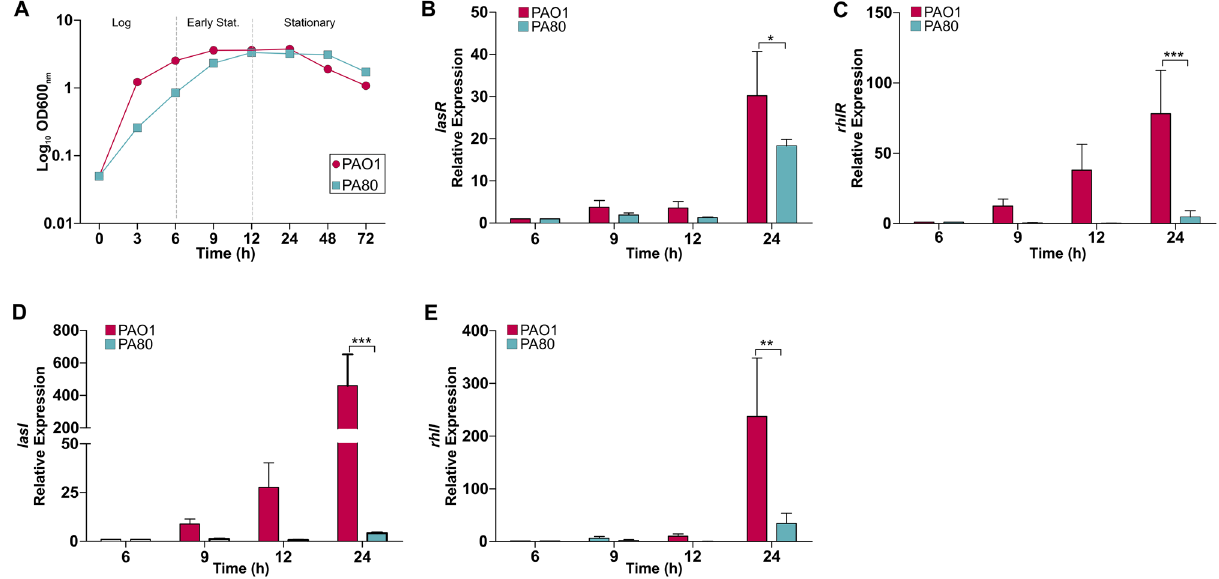
Figure 5. CF isolate PA80 does not express any QS regulatory genes. ( A ) Growth of PAO1 in comparison with rhlR mutant isolate PA80. Relative expression of PAO1 and PA80 during log and stationary growth phases. Relative expression levels of QS regulatory genes ( B ) lasR, ( C ) rhlR ( D ) lasI and ( E ) rhlI in both PAO1 and PA80. Expression levels are shown as the mean relative expression ratios to log phase levels (i.e. 6 h). Error bars represent the S.D (biological triplicates). Data was analysed using a one-way ANOVA followed by a Dunnett’s multiple comparison test comparing each time point to log phase levels (i.e. 6 h) (* p < 0.05, ** p < 0.01, *** p < 0.001).